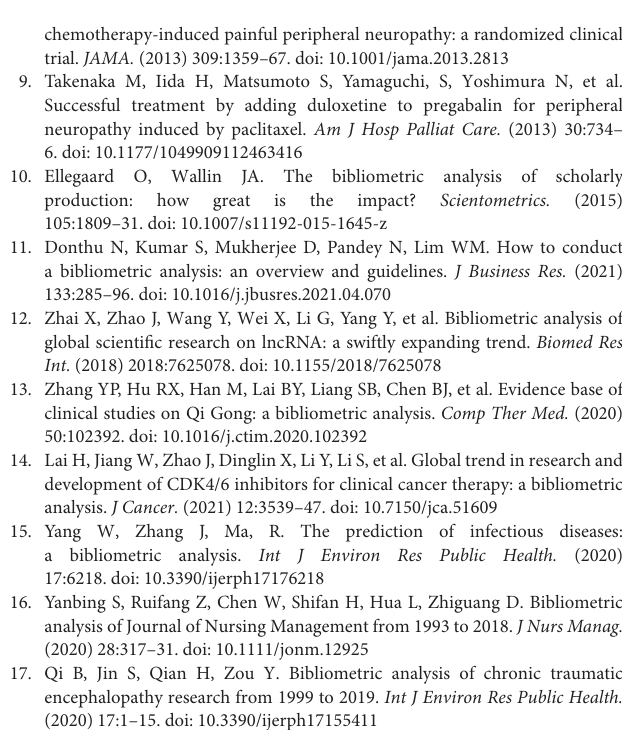
Supplementary Figure 1 | The collaborative relationships between different